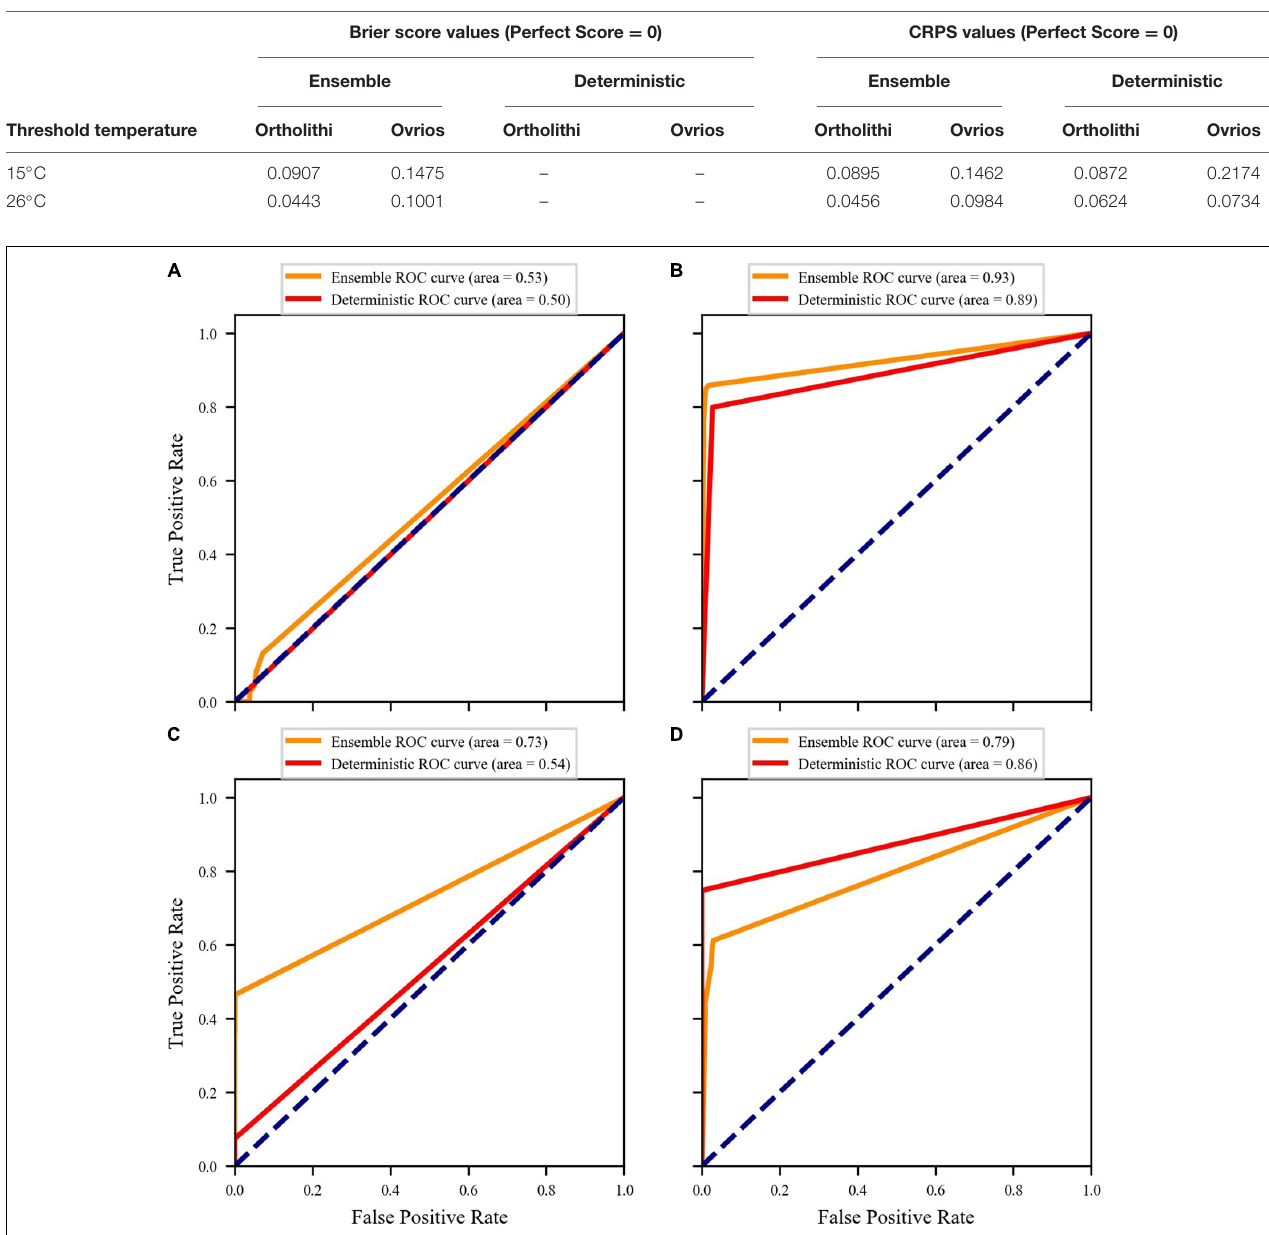
FIGURE 6 | Receiver operating characteristics (ROC) curves for two stations (A) 15 ◦ C threshold – Ortholithi, (B) 15 ◦ C threshold – Ovrios, (C) 26 ◦ C threshold – Ortholithi, (D) 26 ◦ C threshold – Ovrios. The dashed line represent the 1:1 line.